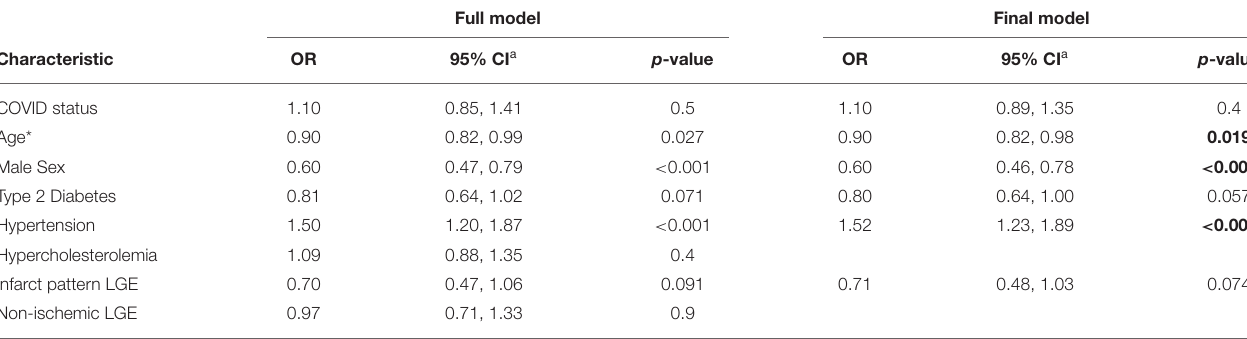
TABLE 3 | Multivariable analysis of global stress myocardial blood flow in the COVID and propensity-matched control